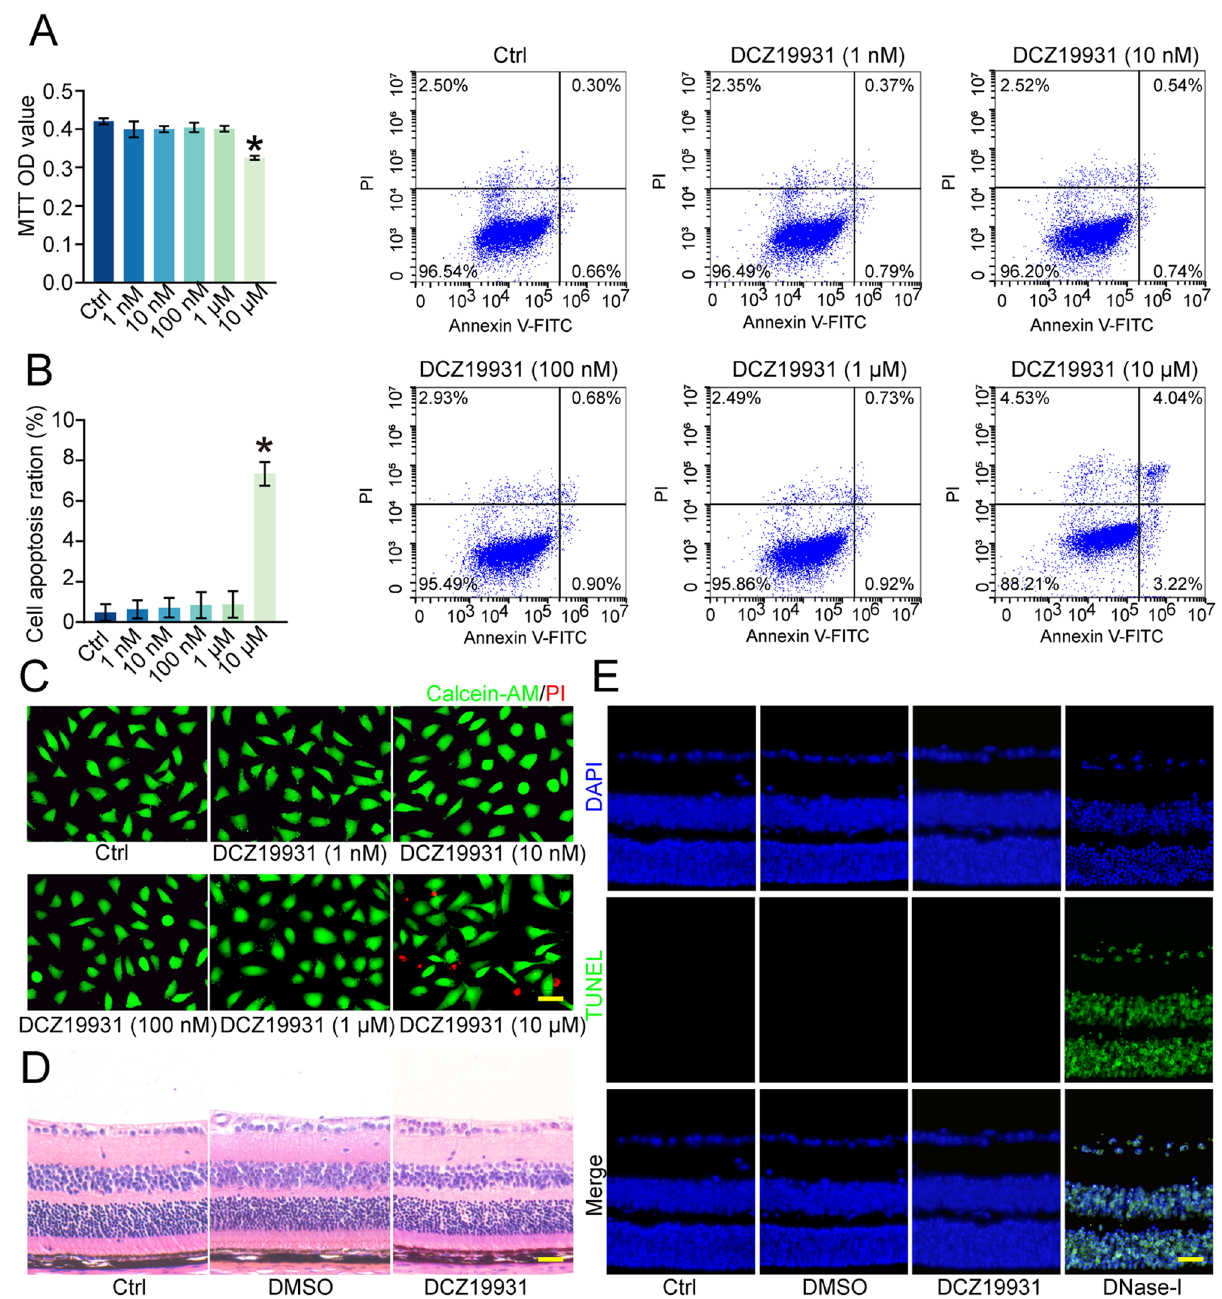
Figure 2. DCZ19931 has no obvious cytotoxicity and tissue toxicity. ( A – C ) HUVECs were incubated with the test concentrations of DCZ19931 (1 nM to 10 μM) or left untreated (Ctrl) for 24 h. Cell viability was measured by MTT assays ( A , n = 4). Flow cytometry using Annexin V-FITC/PI double staining ( B , n = 4) and Calcein-AM/PI staining ( C , n = 4, scale bar, 20 μm) was performed to detect the apoptosis of HUVECs. ( D , E ) C57BL/6J mice received intravitreal injections of PBS (2 μL, Ctrl), 10% DMSO (2 μL), or DCZ19931 (2 μL, 1 μg/ μL) for seven days. H&E staining ( D , n = 5 animals per group, scale bar, 50 μm) and TUNEL staining assays were performed to detect retinal histological changes and retinal cell apoptosis ( E , n = 5 animals per group, scale bar, 50 μm). DNase I was detected as a positive control in TUNEL staining assays. Statistical significance was evaluated by one-way ANOVA followed by Bonferroni post hoc test. * P < 0.05 indicated significant difference between the marked